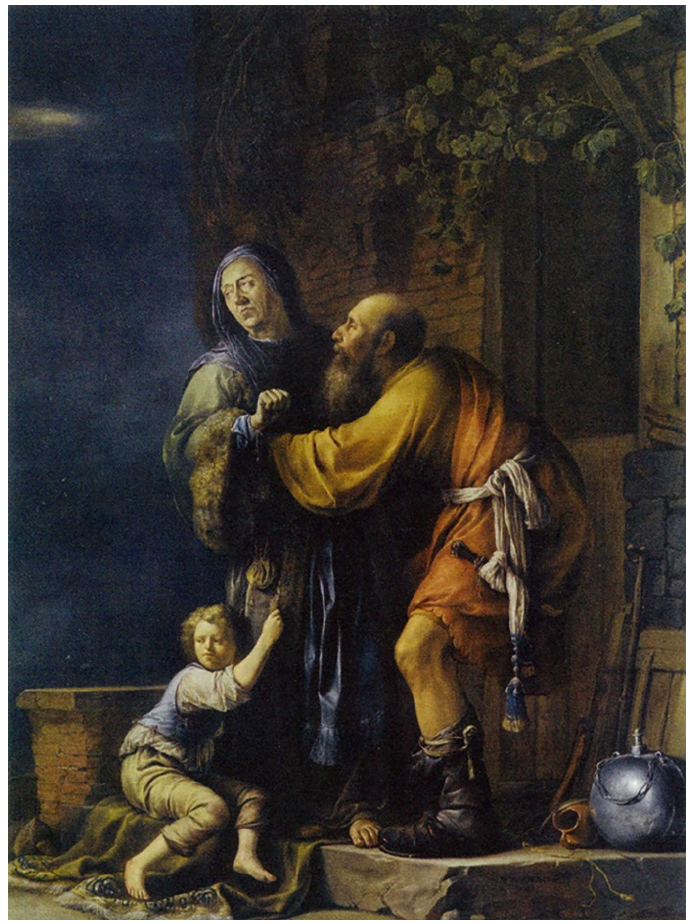
Figure 12. Willem Batsius, 1631. London, Sotheby’s, 9 December 2010.